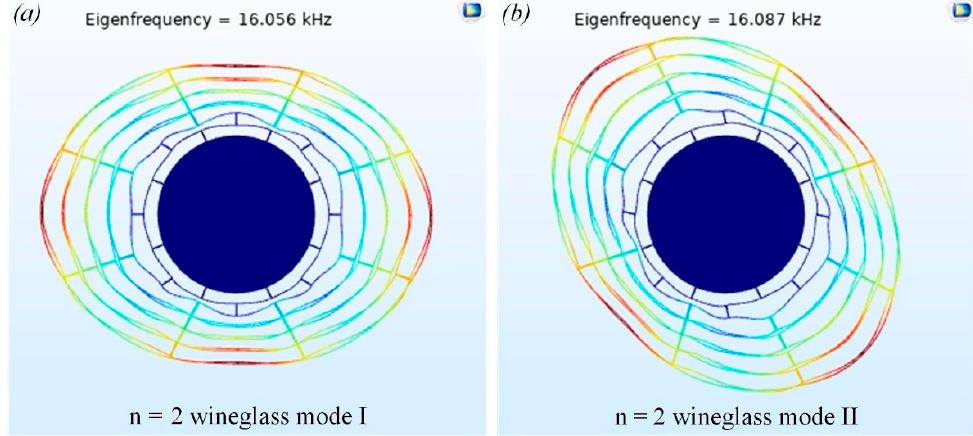
Figure 2. The n = 2 wineglass mode I ( a ) and the n = 2 wineglass mode II ( b ).